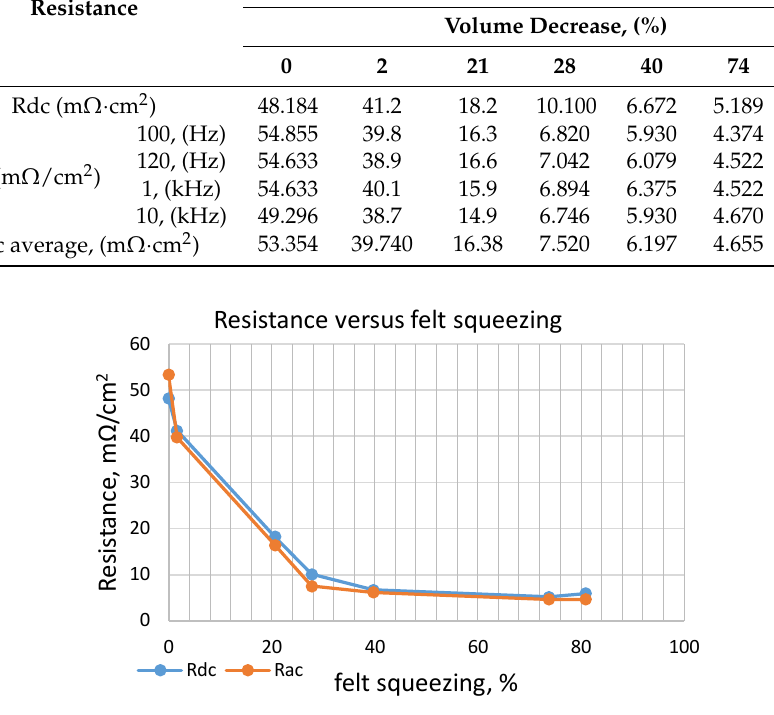
Figure 8. Resistance of a dry felt versus volume compression.